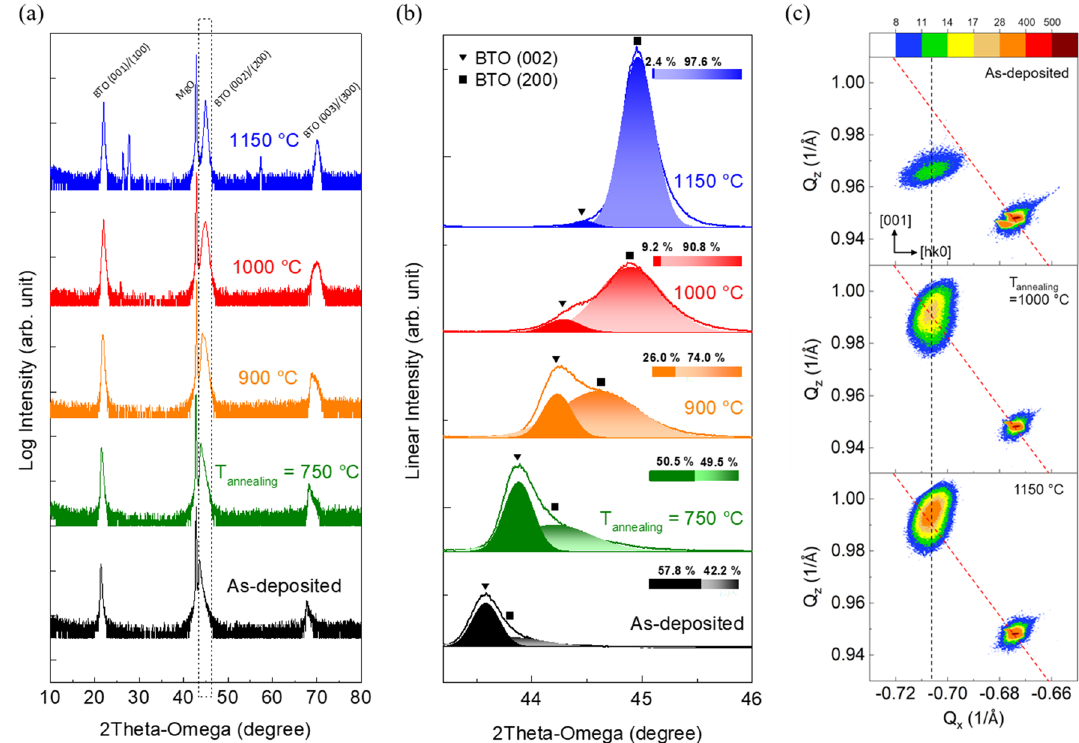
Figure 3. ( a ) X-ray diffraction (XRD) patterns of as-deposited BTO film and BTO films annealed at 750, 900, 1000, and 1150 °C. ( b ) X-ray diffraction 2θ-ω scan of the BTO (002)/(200) peaks (the area in the dashed box in ( a )). Solid line indicates the experimental XRD spectrum, and the combined XRD peak is analyzed as the sum of two Gaussian curves. The triangle mark and the square mark represent the position of (002) and (200) peak, respectively. The composition ratios of each pick are expressed as a ratio of area. ( c ) Reciprocal space mapping (RSM) of the 224 diffraction of as-deposited BTO film and BTO films annealed at 1000, 1150 °C. The color bar represents the intensity of the measured signal. Red dashed line corresponds to the condition of strain relaxation. The black dashed line is parallel to the [001]